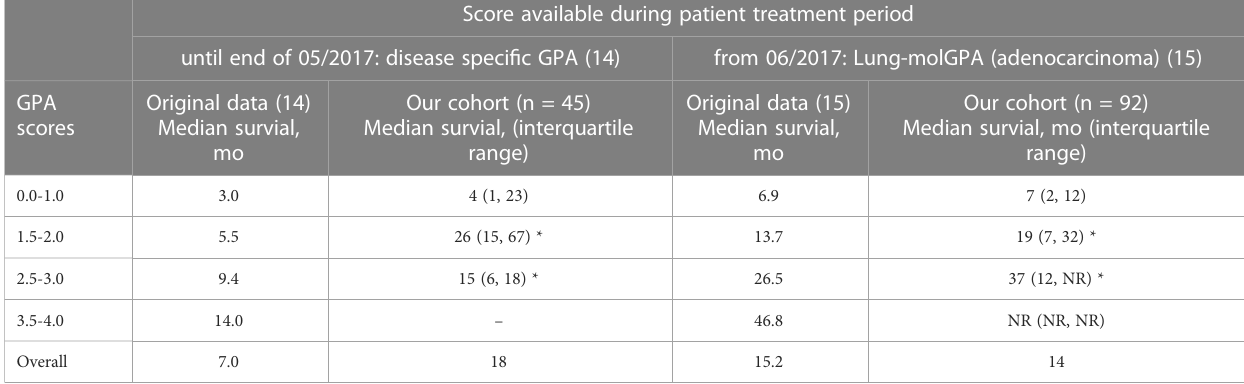
TABLE 3 Comparison of the expected median OS according to the available prognostic score and the actual median OS of patients treated in the time period. Score available during patient treatment period until end of 05/2017: disease speci fi c GPA